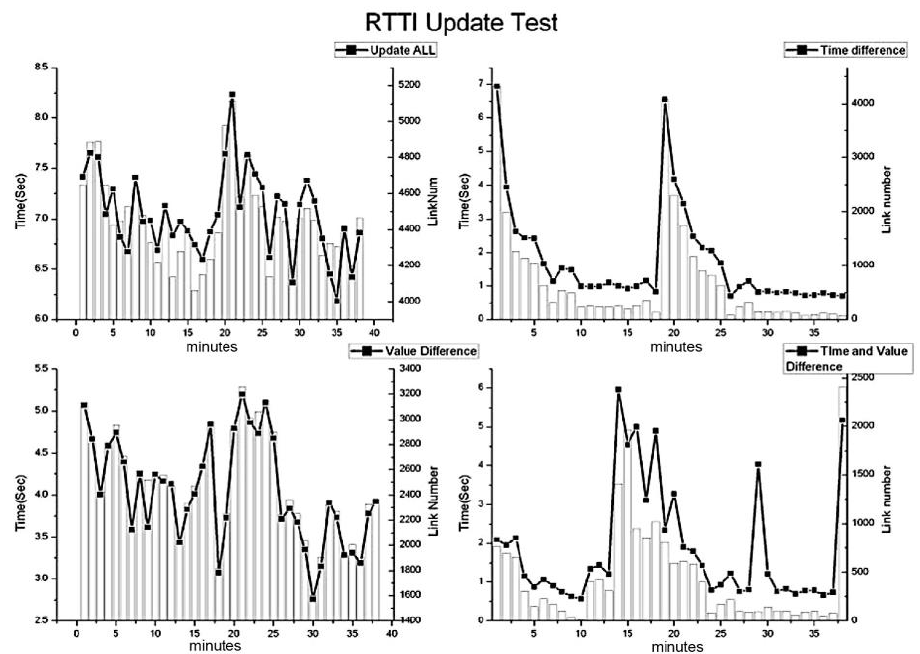
Figure 9. Time cost and the recorded number for updating real-time traffic information (RTTI) every 5 min.